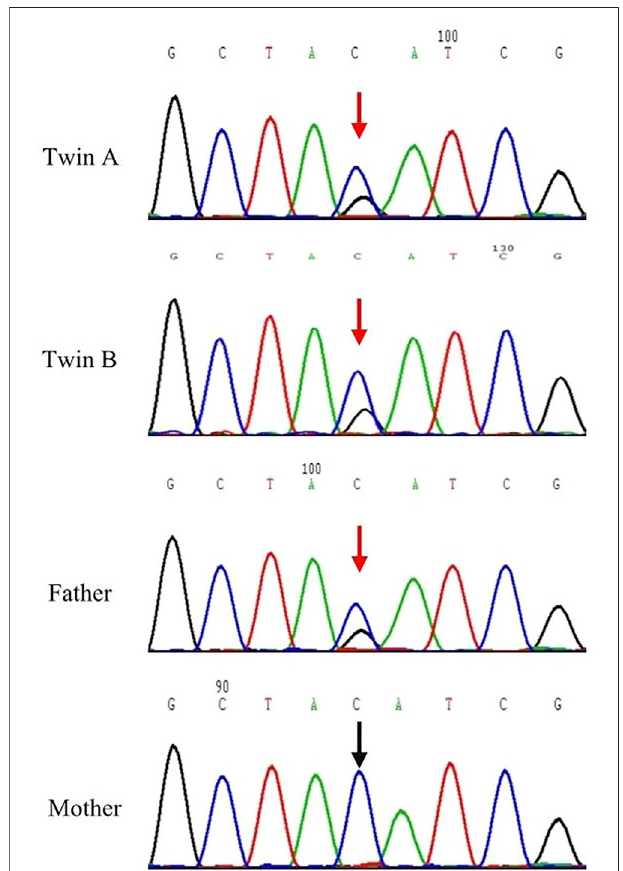
FIGURE 2 | Sanger sequencing results for DNAH11 c.2436 of Twins A, B and their parents. The DNAH11 c.2436 C > G; p.Y812 * variant was detected in the Twins A, B and their father. Red arrows designate variant